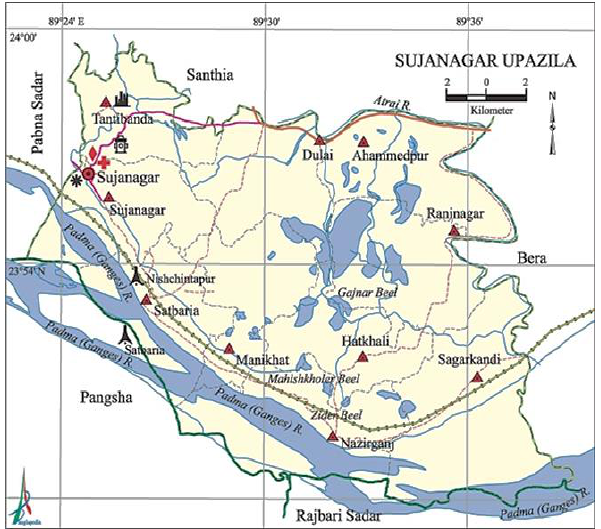
Figure 1: Schematic diagram of the study area, Sujanagar Upazila (Source: Banglapedia)